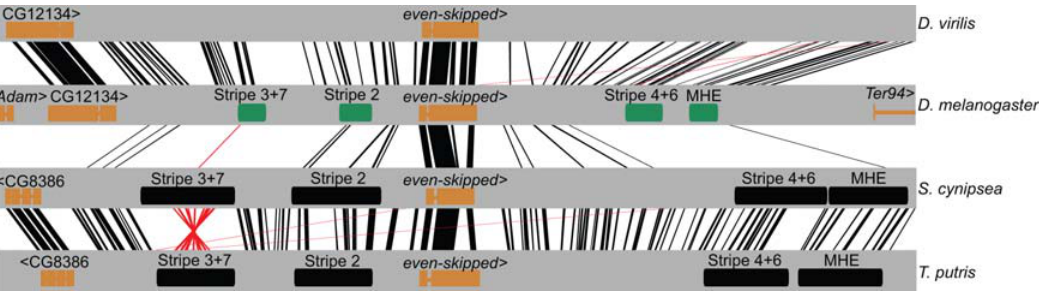
Figure 2. Conservation within and between sepsids and Drosophila . The eve locus (20 kb flanking the eve protein-coding gene) is shown for two Drosophila ( D. melanogaster and D. virilis ) and two sepsid species ( S. cynipsea and T. putris ), centered on the eve homeodomain. Black lines represent significant BLASTZ [15] hits on the plus strand, red lines on the minus strand (BLASTZ parameters: K=1800, with chaining). Verified D. melanogaster enhancers are shown in green and predicted sepsid enhancers in black. Note that only a subset of D. melanogaster eve enhancers are shown here; all BLASTZ matches between D. melanogaster and S. cynipsea fall within known enhancers with the exception of those falling within 500 bp of the transcription start site in D. melanogaster